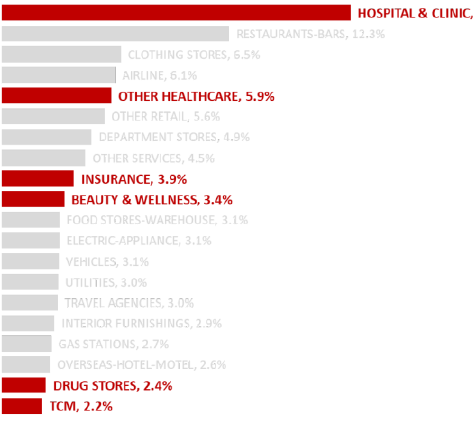
Figure 5. Spending by merchant category.